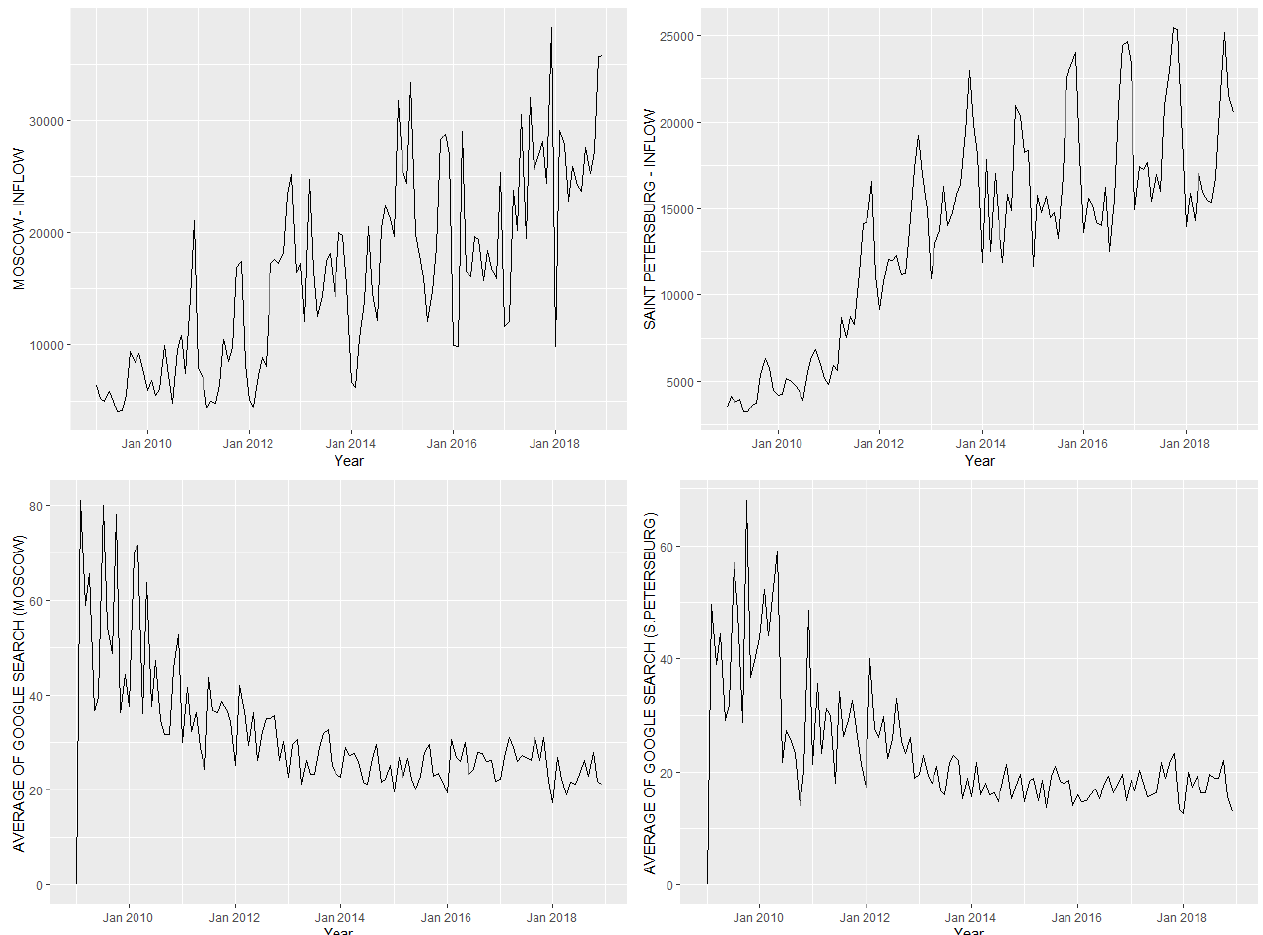
Figure 2. Monthly migration inflows in Moscow and Saint Petersburg, and monthly averages for the three Google searches (“ переезд в « название региона »”, “ работа в « название региона »”,“ жилье в « название региона »”). Table 3. Seasonality tests for the monthly migration inflows in Moscow and Saint Petersburg. Seasonality